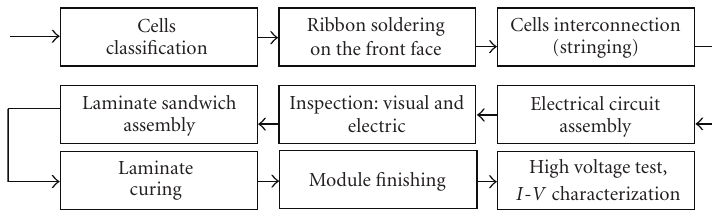
Figure 4: Flow chart of the solar module fabrication process.